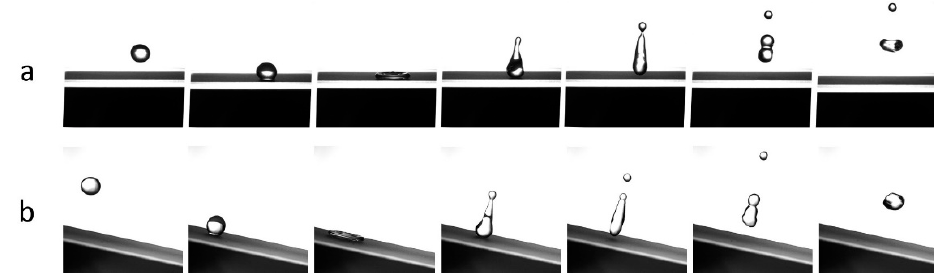
Figure 4. Slow motion sequence acquired by the high-speed camera at 3500 fps (Sprinter HD, Optronis) of water droplet impact with clean SH coating. ( a ) Flat plane (180°), ( b ) 30° tilted surface. Spherical drop diameter about 2 mm.